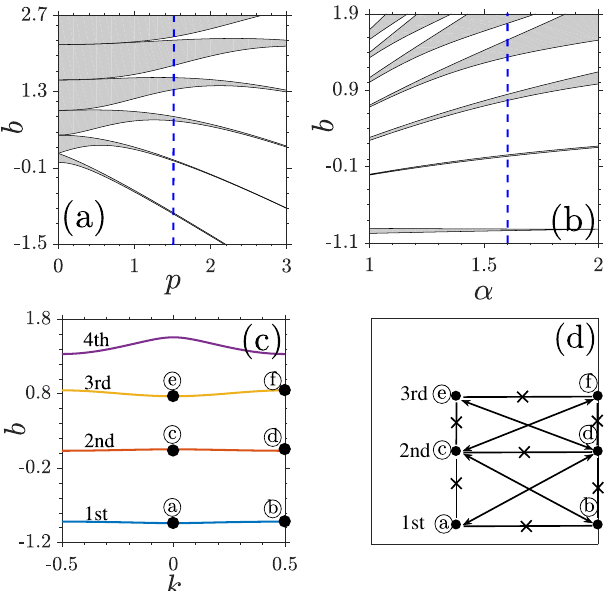
Figure 1. Bandgap structure at ( a ) α = 1.6 and ( b ) p = 1.5. ( c ) Bandgap spectrum at p = 1.5 and α = 1.6. ( d ) A simplified scheme for illustrating the symmetry relation between LBWs.